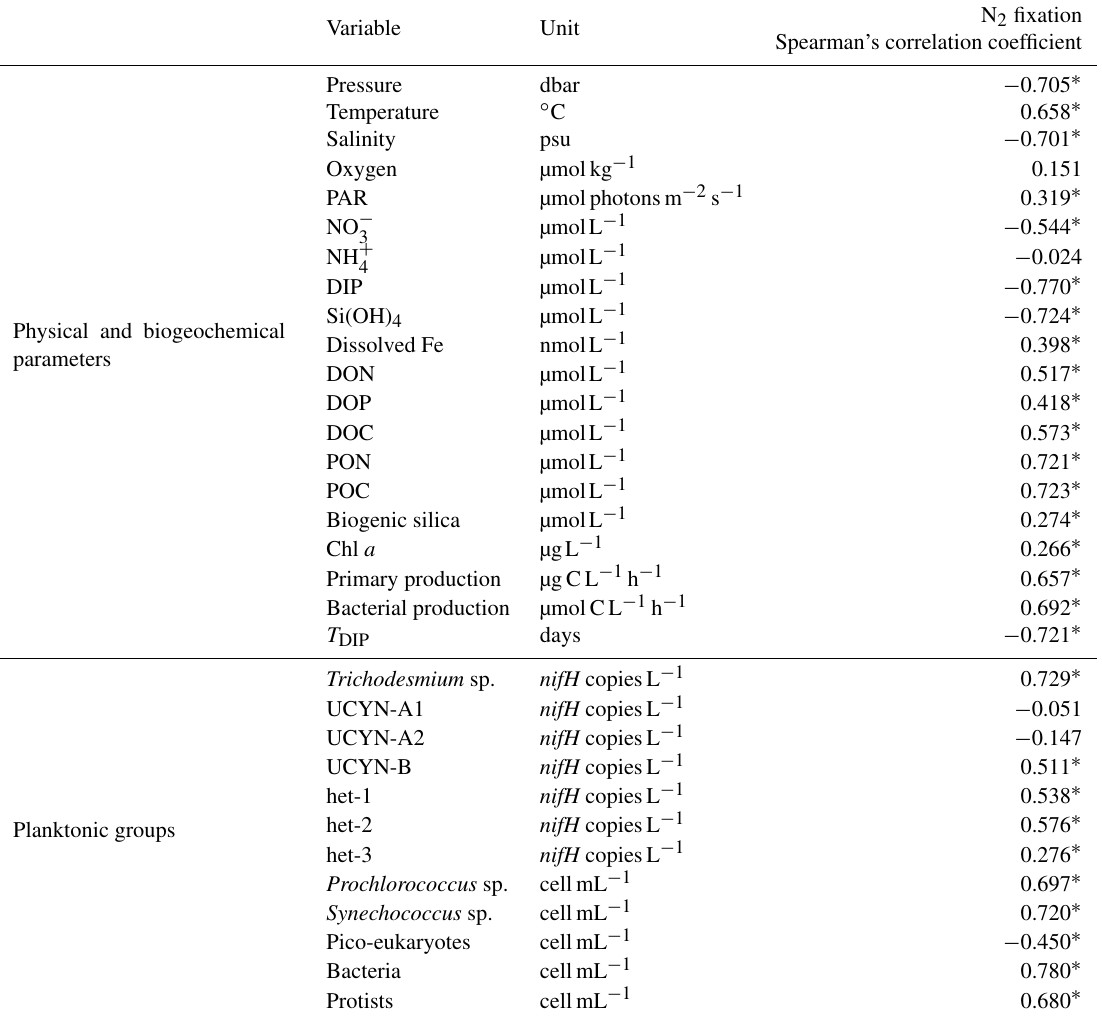
Table 2. Summary of relationships between measured N 2 fixation rates and various physical and biogeochemical parameters. Also shown are correlations between measured rates and the several diazotrophic or non-diazotrophic planktonic groups enumerated at the respective stations. The corresponding unit is given for each parameter, and Spearman’s rank correlation ( n = 102, α = 0.05) is provided; significant correlations ( p < 0.05) are indicated by an asterisk ( ∗